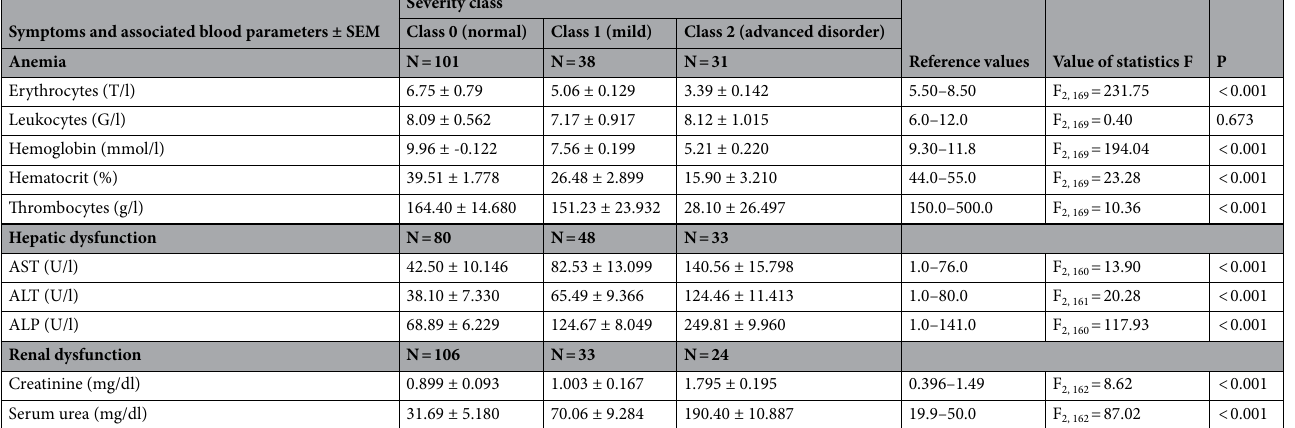
Table 2. Comparison of selected blood parameters in classifying the severity of the main symptoms in canine